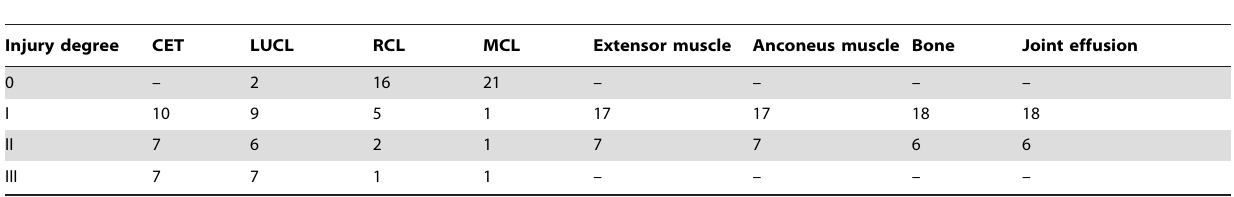
Table 4. Results of injuries in patients with lateral